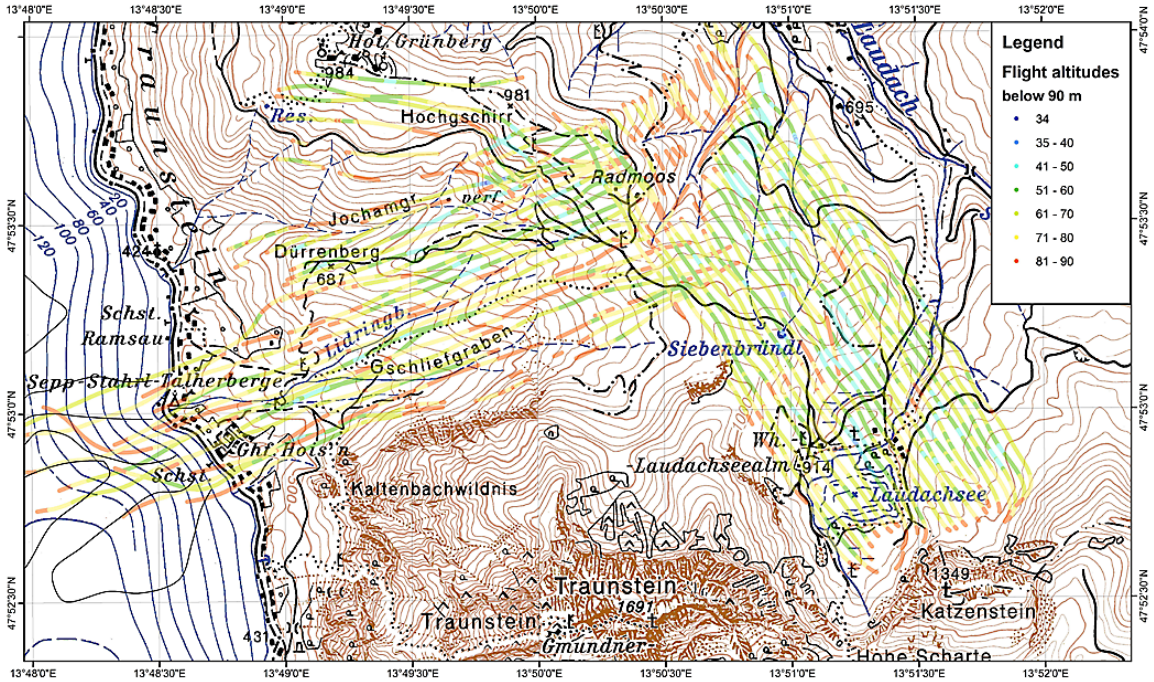
Fig. 5. Flight lines of the Gschliefgraben airborne survey; colours indicate the actual sensor height (m) above topography.